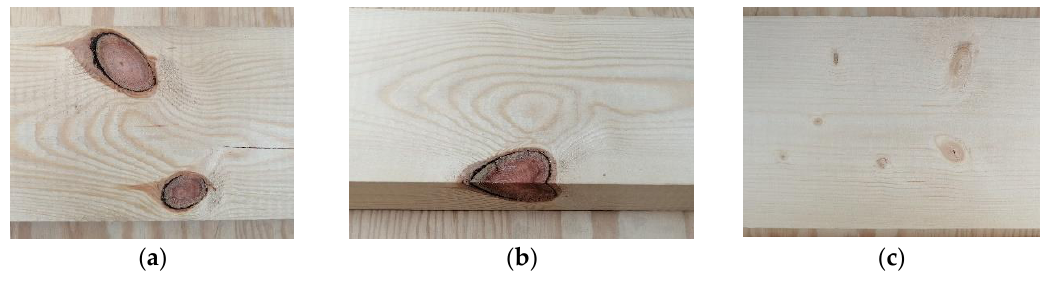
Figure 1. The examples of knots from: ( a , b ) Scots pine and ( c ) Norway spruce.